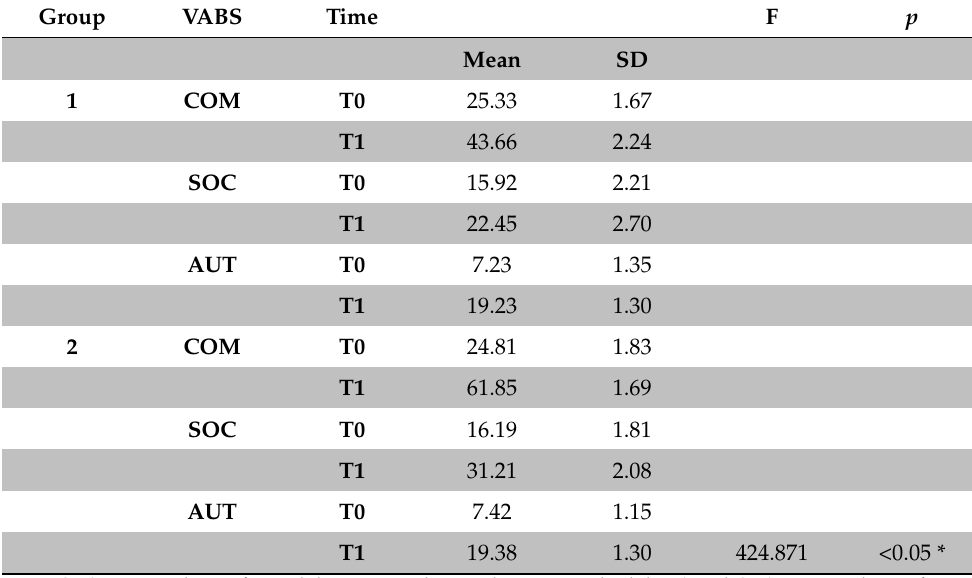
Table 4. Effect of the scale * time * group interaction on the VABS test. Group VABS Time F p